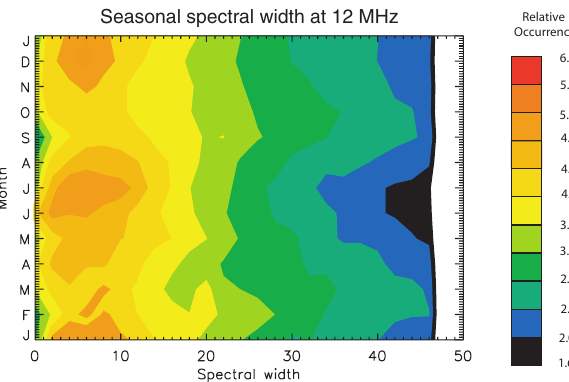
Fig. 7. Monthly averaged variation of low spectral widths with sea- son for the Hankasalmi HF radar operating during 1999–2000 using beams 6–10 for range gates 0 to 6 and operating at 12MHz. Occur- rence rates have been normalised for each month. (a) Raw meteor echoes (b) Meteor echoes processed for ionospheric